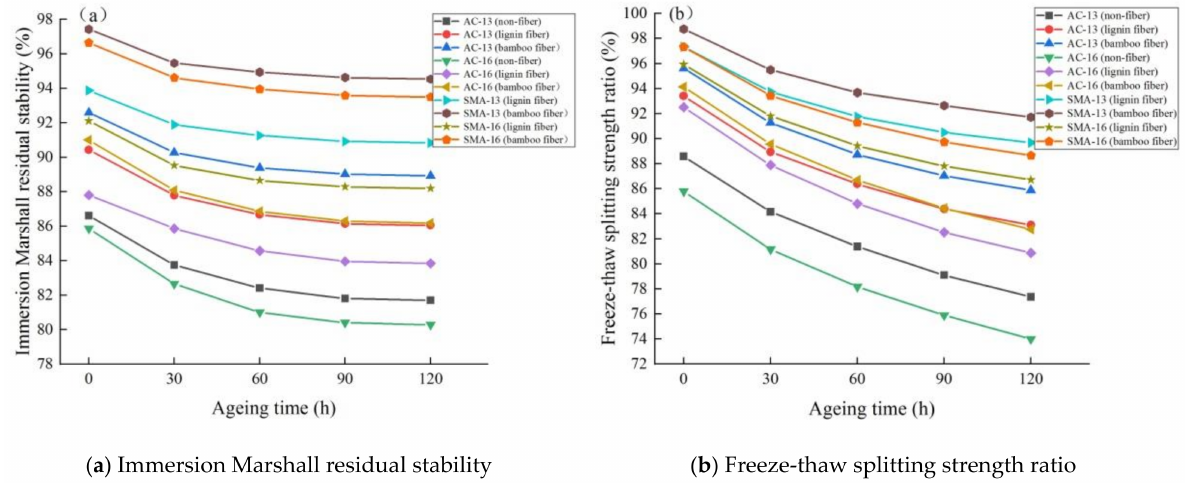
Figure 6. Test results of moisture stability of fiber asphalt mixture under different ageing